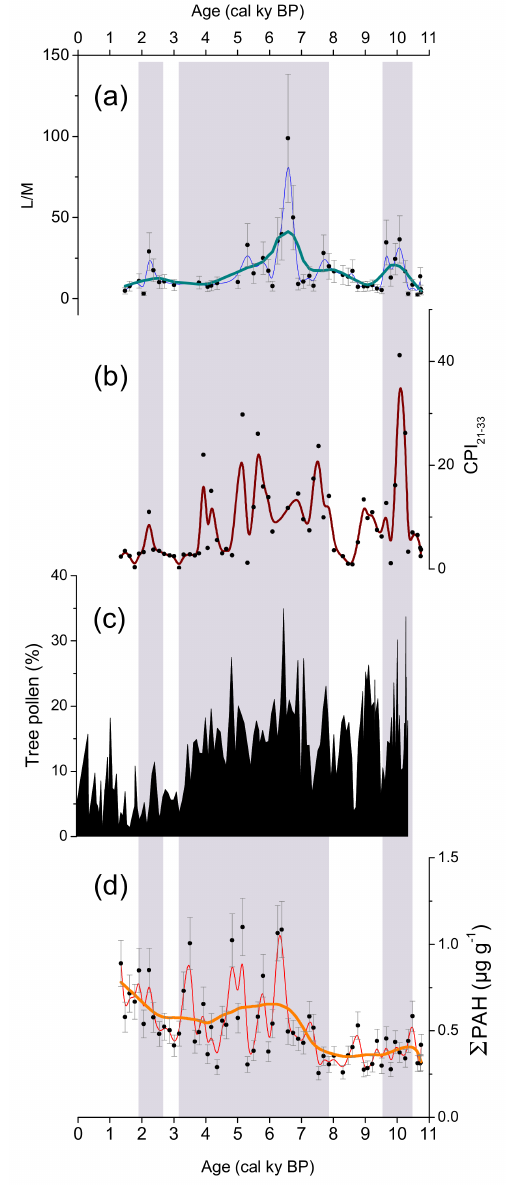
Figure 3. (a) L / M ratio values (black points) with absolute error bars (grey); LOWESS smoothing with SPAN parameter 0.2 (teal), b-spline interpolation (blue). (b) CPI ratio values (black points); b- spline interpolation (dark red). (c) Tree pollen (%) from Zhao et al. (2011). (d) Sum of PAH concentrations, data points (black) with absolute error range (grey), LOWESS smoothing with SPAN pa- rameter 0.2 (orange), b-spline interpolation